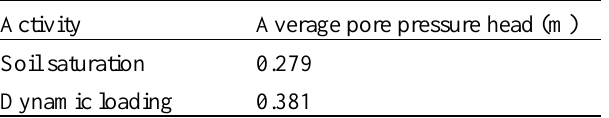
Average Pore Pressure Heads in Treated 1-g Physical Model- II with Treatment Adjacent to